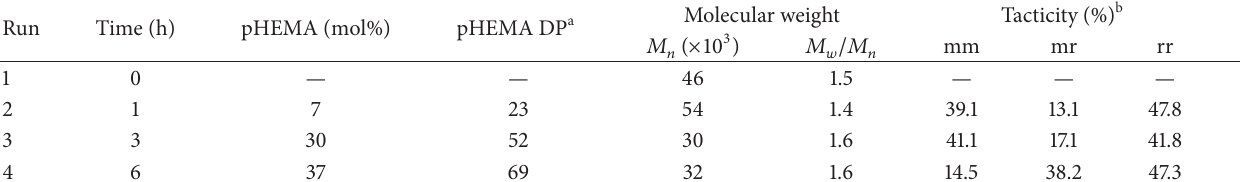
a DP: degree of polymerization. b